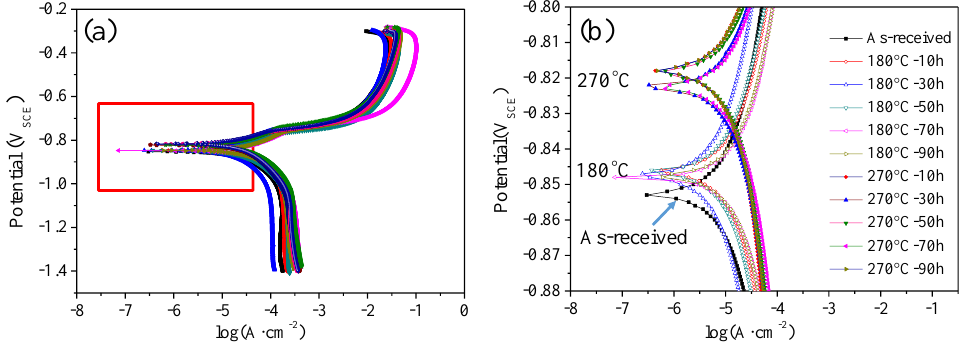
Figure 5. ( a ): Polarization curves of the studied AlSi10Mg(Cu) alloy under different temperatures and time in 3.5 wt % NaCl solution; ( b ) partial magnification of polarization curves marked by a red box in ( a ).